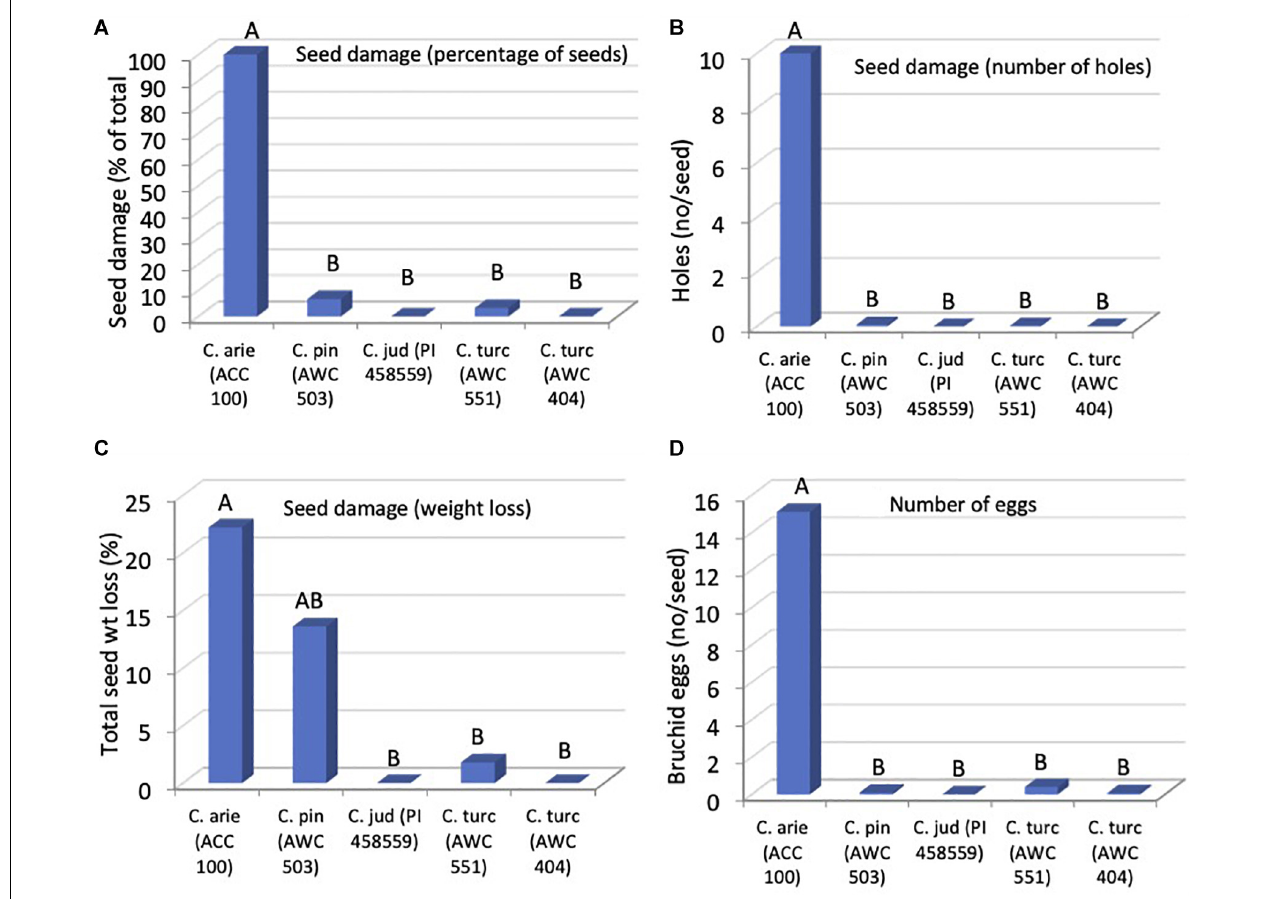
FIGURE 8 | Bruchid resistance in wild compared to domestic Cicer species in terms of seed damage (A) , number of holes (B) , weight loss (C) , and number of eggs (D) , from a no-choice feeding test at Akdeniz University. Letters represent accession group membership from Duncan multiple range test, different letters indicate significant difference ( P <